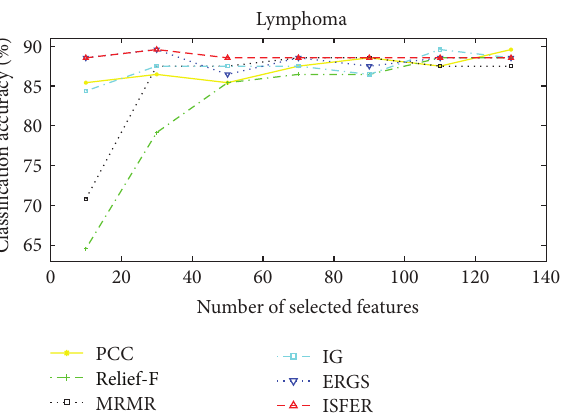
Figure 5: The classification accuracies of different algorithms on the Leukemia2 database.